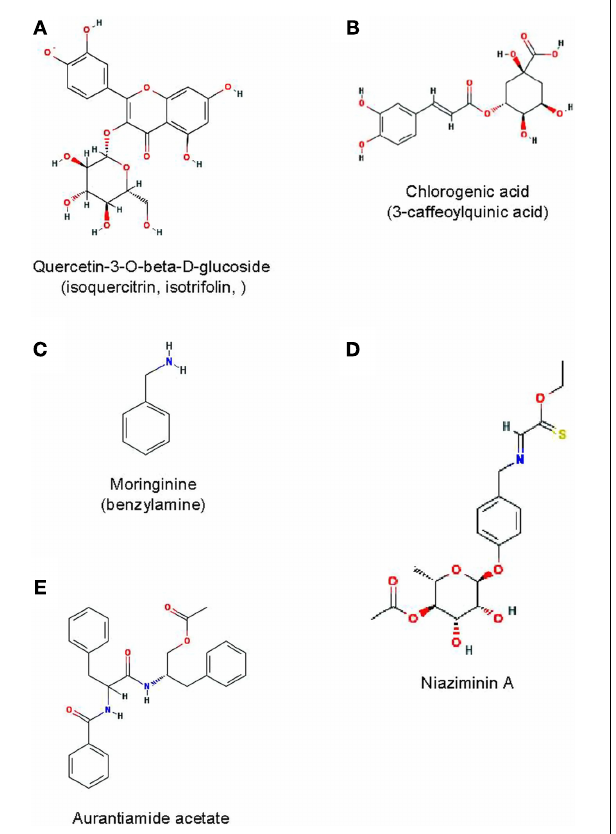
FIGURE 3 | Some bioactive phytochemicals found M. oleifera leaves. Their structures were obtained from the online in the PubChem database at